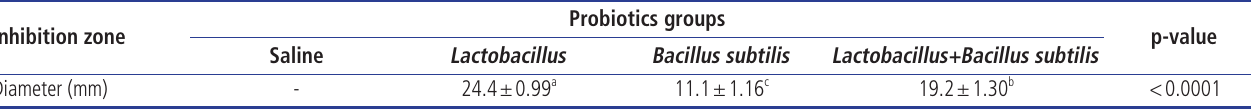
Table 2. Effect of probiotics on the diameter of inhibition zone of Escherichia coli without resistance in vitro Inhibition